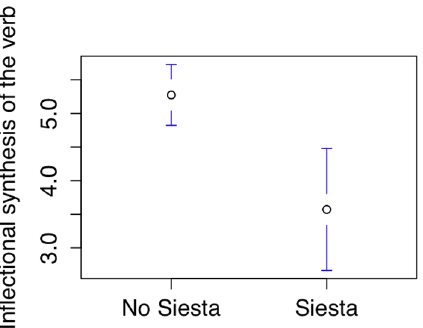
Figure 5. Relationship between siestas and number of grammatical categories a verb can